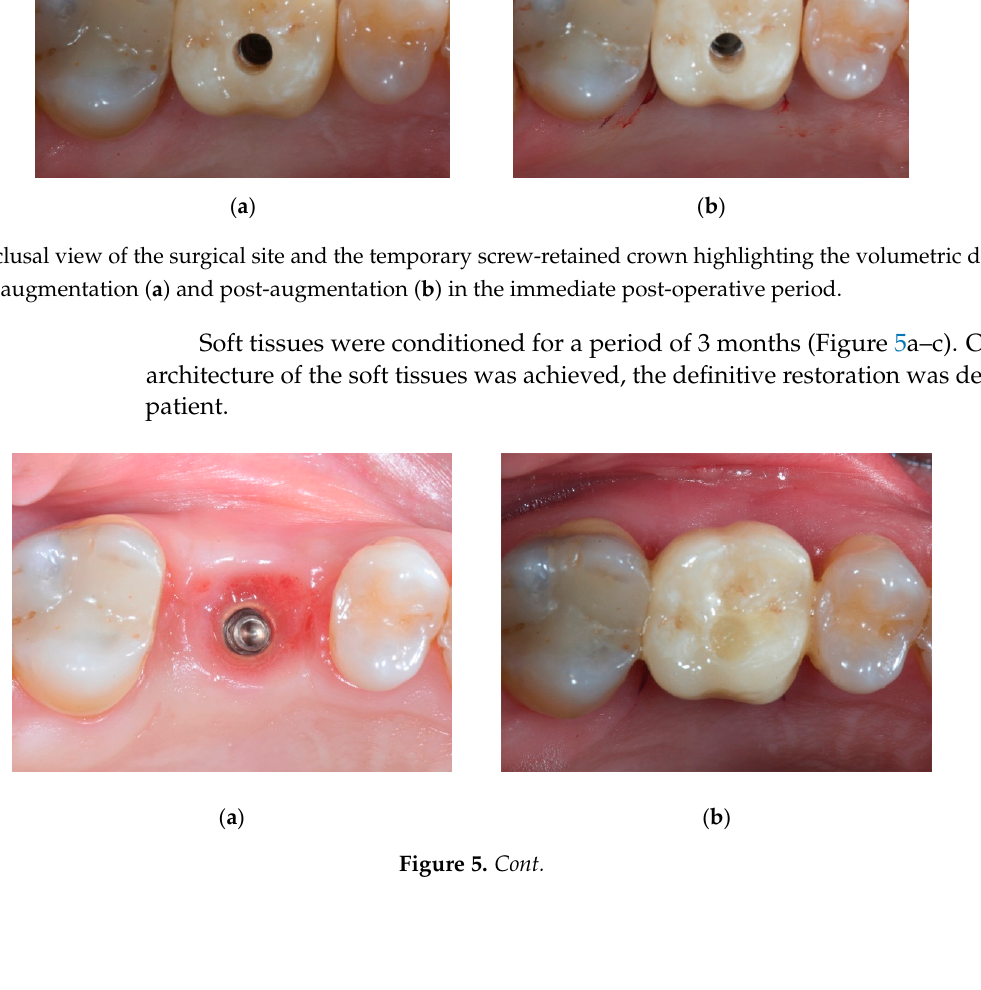
( c ) Figure 5. Intraoral view of the conditioned soft tissues after a healing period of 3 months: ( a ) occlusal view of the aug- mented peri-implant soft tissues shaped according to the emergence profile of the temporary crown. ( b ) Occlusal view of the augmented volume with the temporary crown in situ. ( c ) Buccal view of the augmented volume with the temporary crown in situ. 3. Discussion Soft tissue grafting is commonly indicated in case of insufficient keratinized gingiva or deficient gingival volume causing aesthetic imperfections and biological issues. The current literature considers autogenous soft tissue graft as the gold standard material, with the palate as the most frequent intraoral donor site, regardless of the surgical proce- dure. Zucchelli et al. compared with a randomized controlled design, sub-epithelial CTG versus de-epithelialized CTG and concluded that there were no differences in terms of discomfort, post-operative pain assessed by intake of analgesics, and bleeding [13]. The only statistically significant difference in the clinical outcomes between the two treatment groups was the greater increase in gingival thickness in those patients treated with de- epithelialized CTGs. The reason lies in the fact that sub-epithelial CTGs are harvested at a deeper level and contain less lamina propria and more fatty and glandular tissue. The authors also demonstrated that healing by secondary intention was not associated with increased post-operative discomfort. On the other hand, the corono-apical dimension of the graft and the residual soft-tissue thickness over the bone had a significant impact on the experienced post-operative pain. Nevertheless, the presence of a donor site necessarily leads to an increased rate of complications. A recent split-mouth cadaver study compared the risk of intra- and post-operative bleeding in relation to different palatal harvesting techniques [14]. The results highlighted how the trapdoor technique may significantly in- crease bleeding complications, due to a higher risk of damaging larger vessels during the